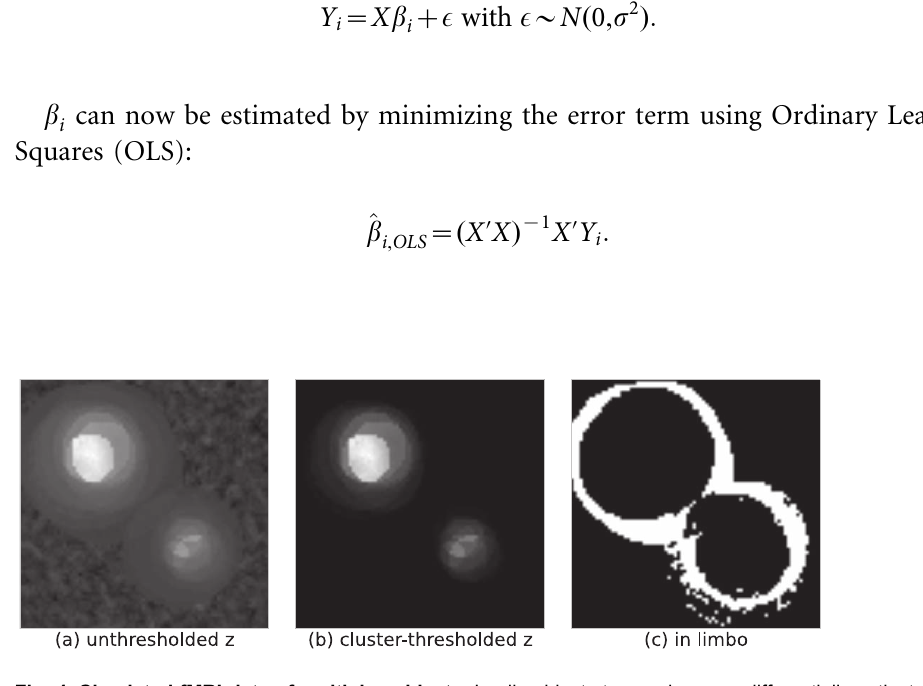
Fig. 4. Simulated fMRI-data of multiple subjects. In all subjects two regions are differentially activated across conditions, but the precise shape, location, and effect size varies. The unthresholded z-map (a) shows large rings of overlapping individual regions of activation. In the thresholded map (b) only a small subset of these rings remains marked as significantly activated. The in limbo map (c) shows that these outer rings are not significantly less activated than some of the least-significantly significantly activated voxel in the inner